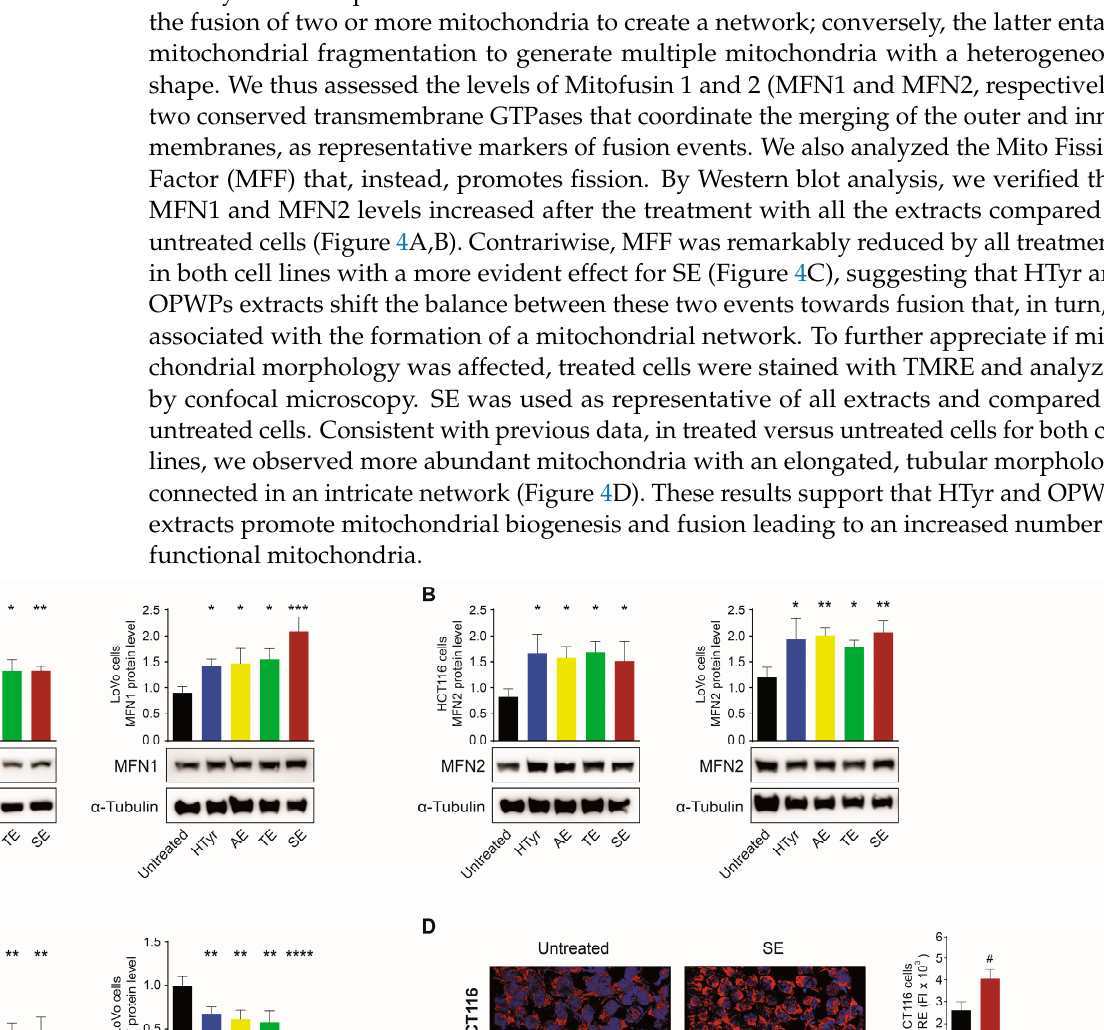
to α -Tubulin or β -Actin, used as loading controls, and show the mean ± SD of three independent